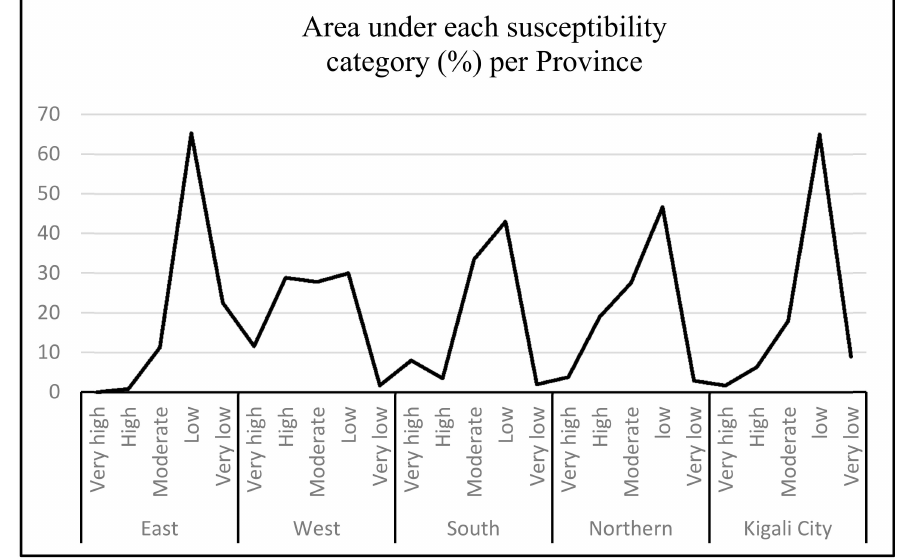
Figure 10. Area under susceptibility category by